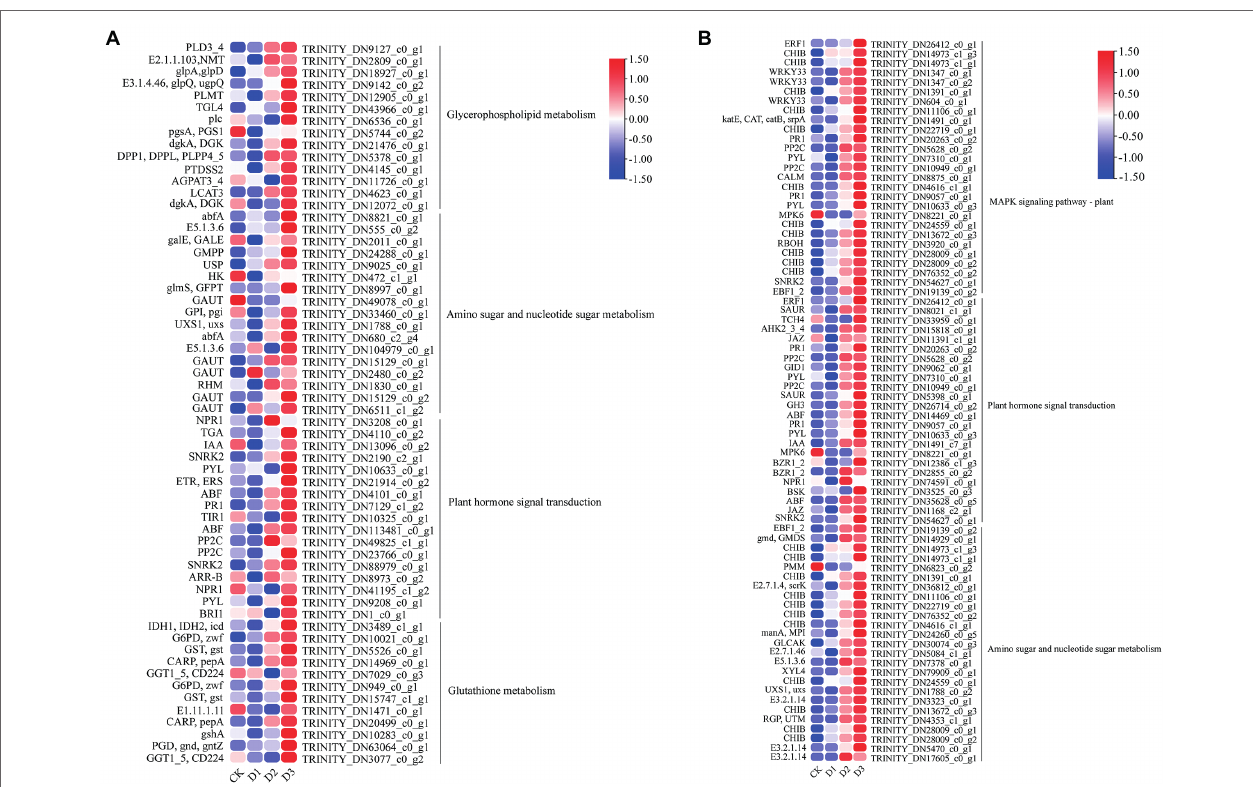
FIGURE 9 | The module unigenes correlation with physiological and biochemical indicators was significant enrichened of KEGG pathways. The (A) is the green module, (B) is the red module. The color was showed the expression values (log 10 (TPM)), and the red represent high TPM. The figures were visualized by